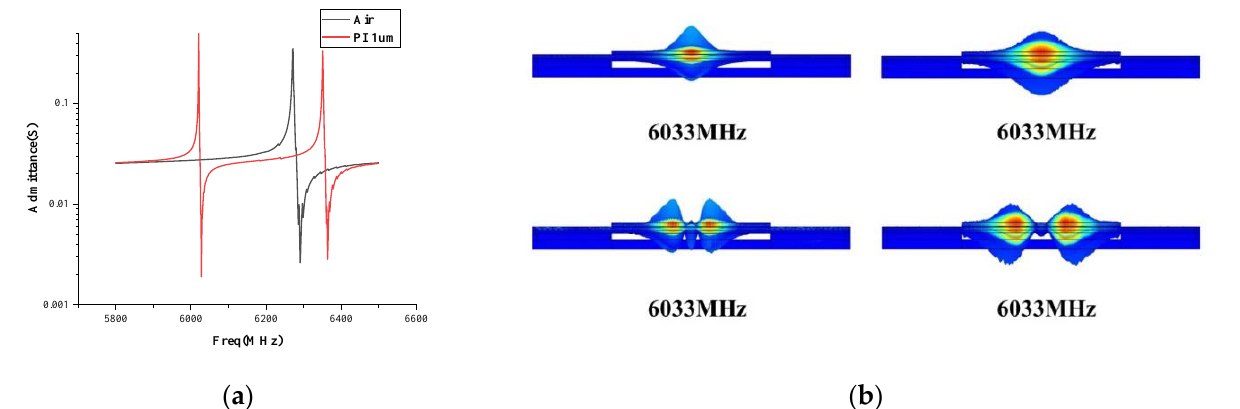
Figure 3. ( a ) Absolute admittance curves for the conventional FBAR and polymer FBAR; ( b ) Reso- nance and antiresonance energy distribution.